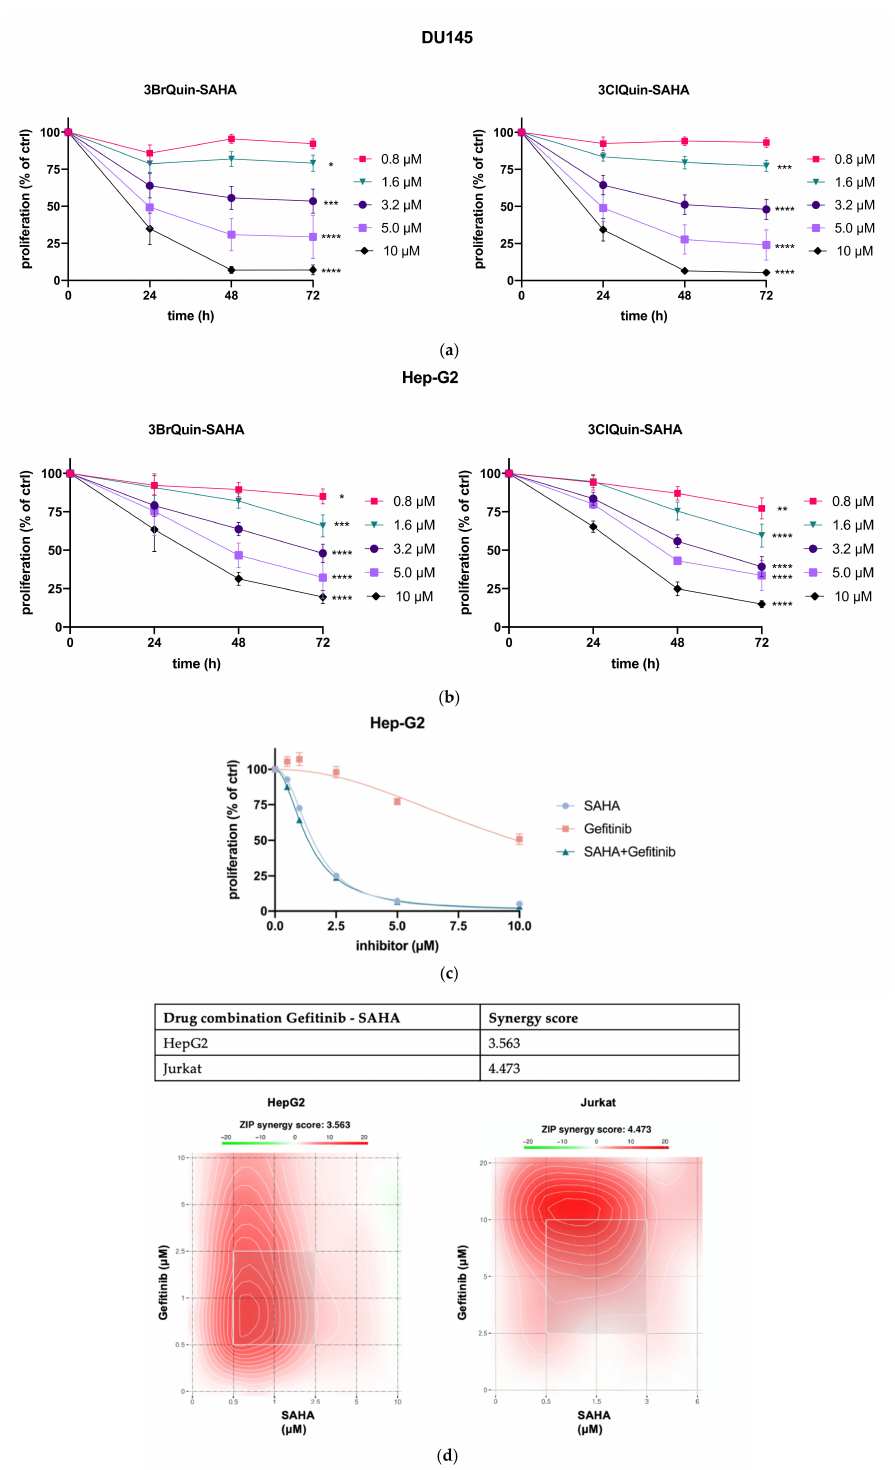
Figure 1. Growth-inhibitory effects of 3BrQuin-SAHA and 3ClQuin-SAHA in ( a ) PCa and ( b ) HCC cells. Time- and dose-dependent growth inhibition is given in percent, relative to untreated control cells, whose proliferation was set to 100%. ( c ) Curve shift experiment of the EGFR inhibitor gefitinib (red) and the HDAC inhibitor SAHA (blue) in a proliferation assay of the Hep-G2 cell line. ( d ) Calculation and visualization of synergy scores for drug combinations of Gefitinib and SAHA on Hep-G2 and Jurkat cells. Zero Interaction Potency (ZIP) synergy score calculated by Synergy Finder 2.0. A ZIP score from -10 to 10 describes that the interaction between two drugs is likely to be additive. Results are shown as means ± SEM of n ≥ 3 independent experiments. * p ≤ 0.05, ** p ≤ 0.005, *** p ≤ 0.0005, **** p ≤ 0.0001; linear